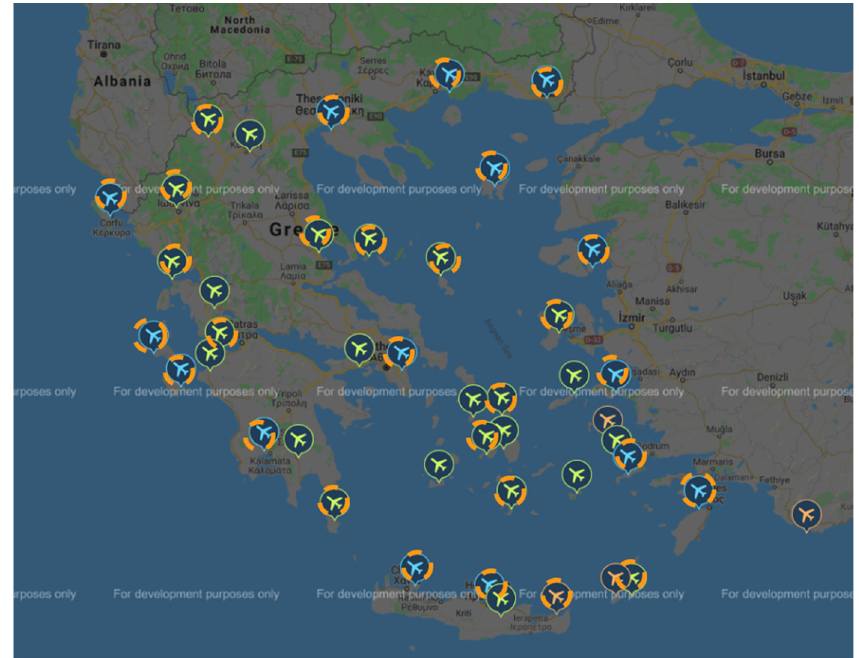
Figure 1. Map of Greece with the 29 Hellenic airports with international pax traffic (Source: HCAA [19]).